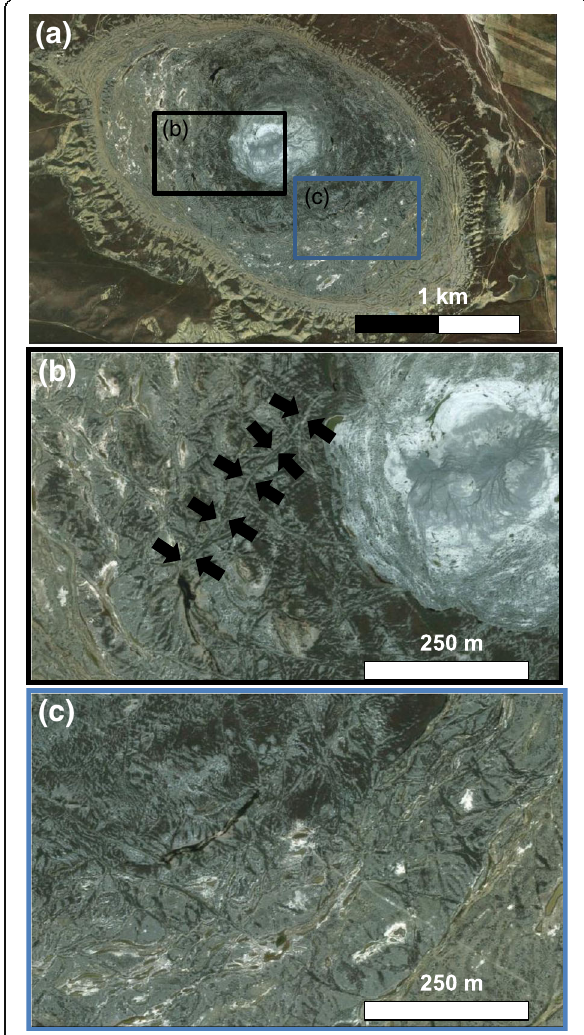
Fig. 14 a USGS Landsat satellite image of Ayaz-Akhtarma mud volcano available from the basemap gallery, https://go.usa.gov/ xnhQV (accessed on Mar 13, 2018). b Expanded image of the black box in a . The lineament sandwiched by black arrows indicates the fault trace identified by Antonielli et al. (2014). c Expanded image of the blue box in a . Similar lines are observed in several